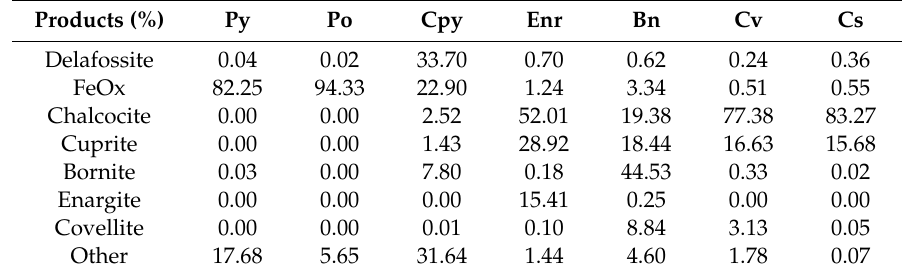
Table 4. Mineralogical composition of sulfide combustion products determined by QEMSCAN ® .